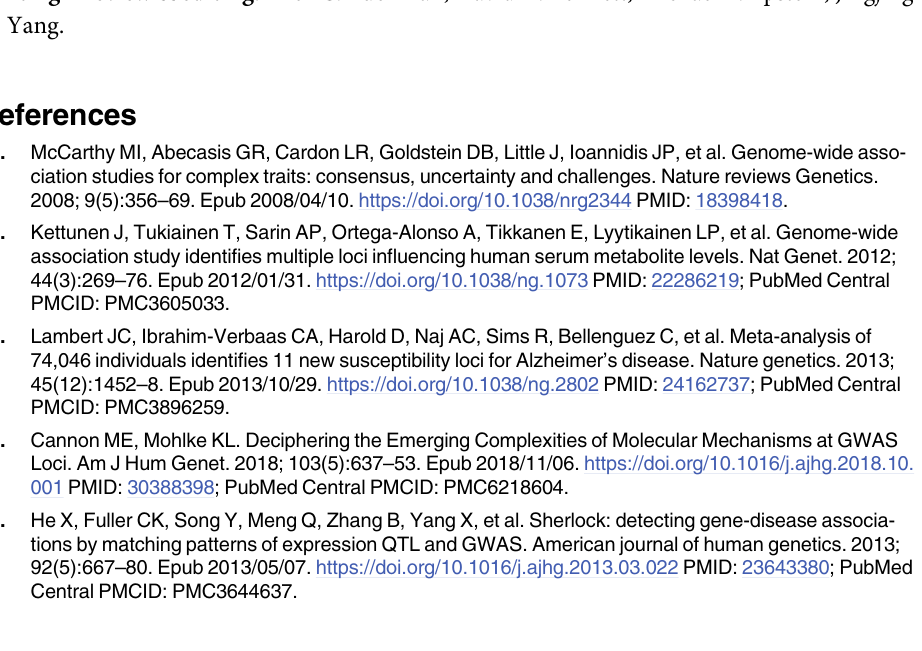
S3 Table. Significant genes identified by VC-TWAS using IGAP summary statistics with filtered cis-eQTL DPR weights. Significant genes were identified with FDR < 0.05. AD risk genes identified by previous GWAS are shaded in grey. S4 Table. Novel significant genes identified by VC-TWAS using summary statistics with BGW weights on IGAP summary statistics. S5 Table. Pros and cons of existing popular TWAS